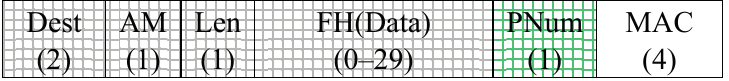
Figure 1. The packet structure of FESA scheme, where MAC is composed of T + 1 subMACs. The byte size of each field is enclosed in parentheses. The acronyms of the fields are destination address (Dest), active message type (AM), message length (Len), packet sequence number